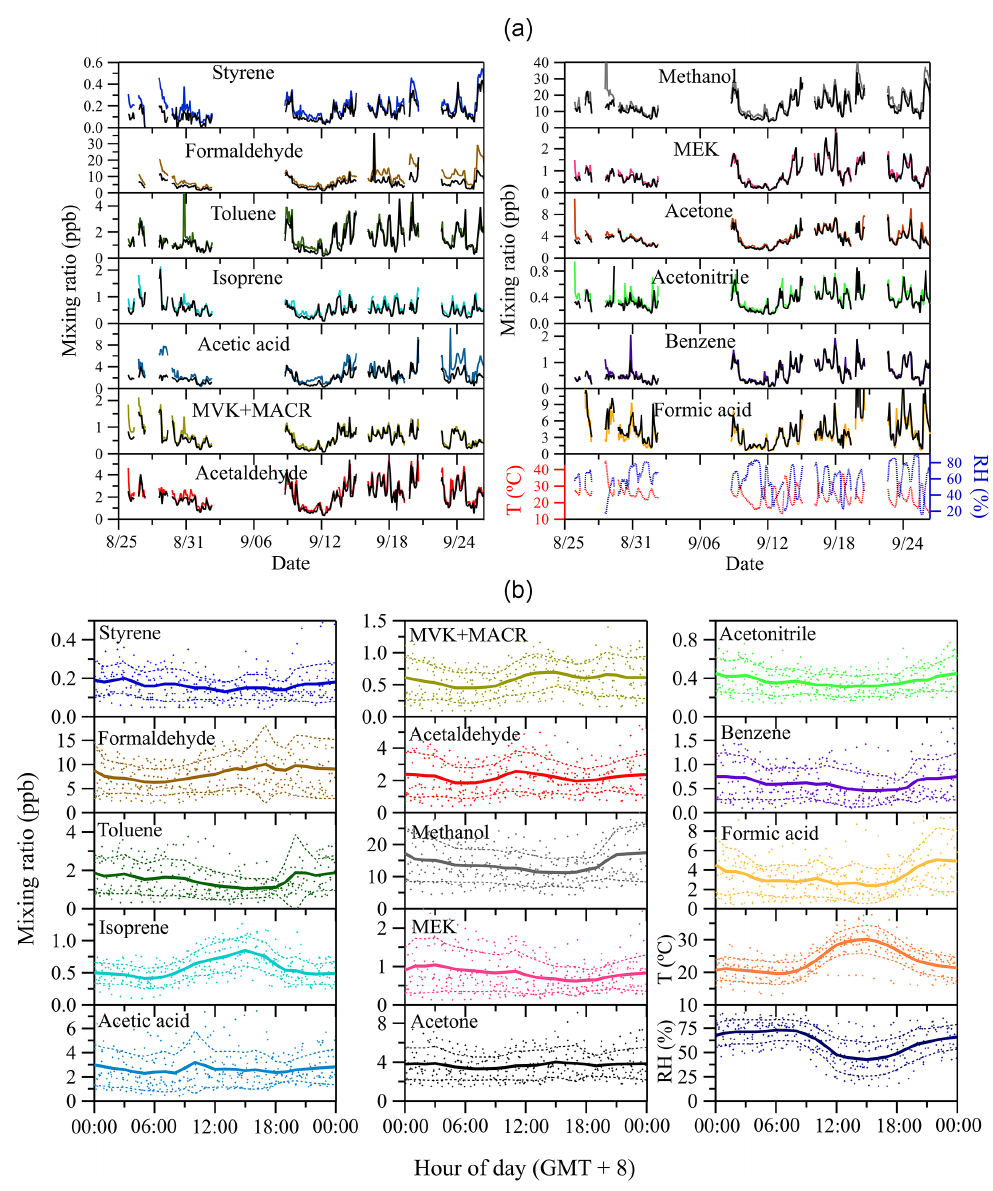
Figure 5. Time series of observed ambient air mixing ratios of VOCs and air temperature and relative humidity (a) , and respective mean diel courses (b) . Colorful lines in (a) denote ambient air mixing ratios at the outlet of the reference tube C r , and black lines represent mixing ratios at the outlet of the sample tube C s . In (b) , symbols denote individual hourly averaged data, and the thick solid lines respective mean diel profile. Thin dashed lines represent 1 standard deviation ( ± 1SD) from the mean